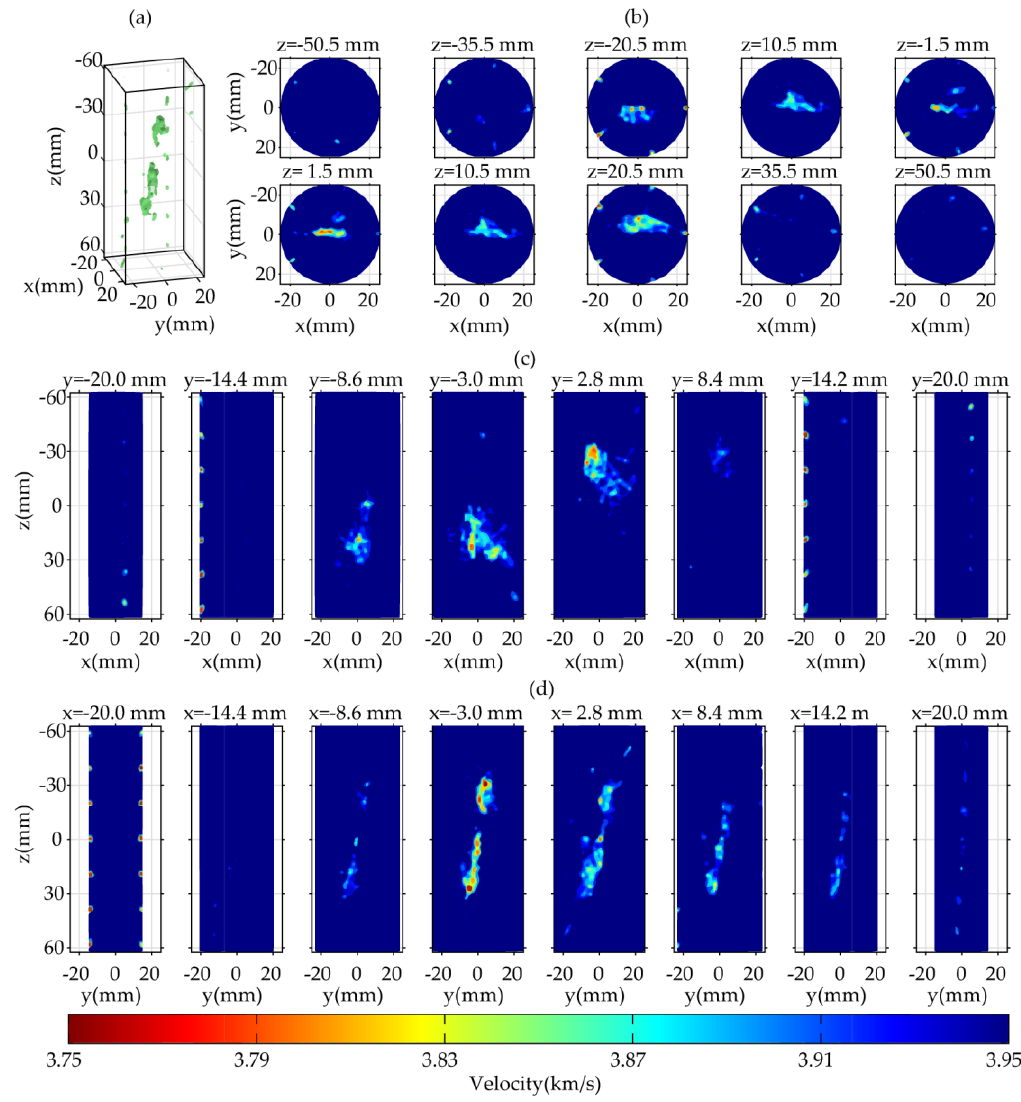
Figure 12. Tomographic images of Tikh under sparse ray coverage case. ( a ) the 3D segmented image; ( b ) the transverse-view profile; ( c ) the coronal-view profile; and ( d ) the sagittal-view profile. The caption of each sub-image in ( b – d ) represents the profile position.